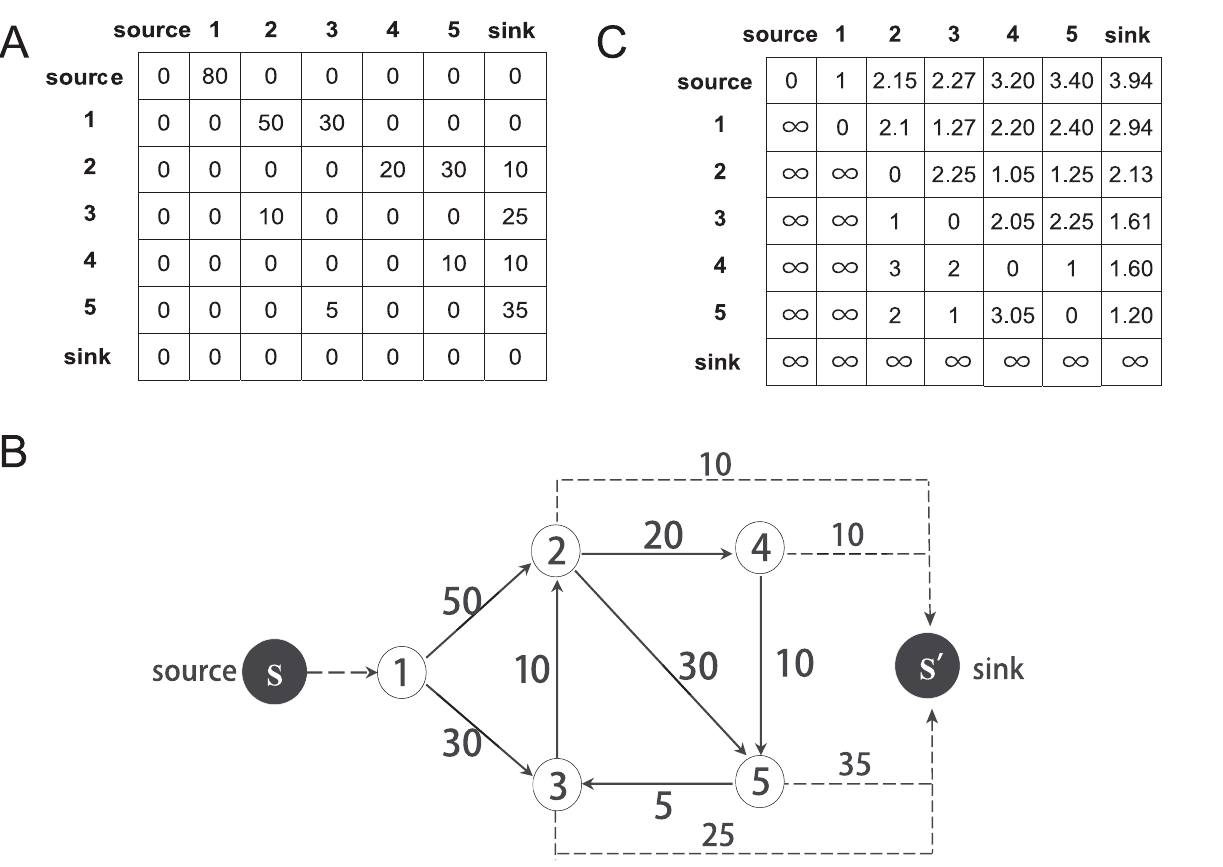
Fig 1. An example attention flow network including 7 nodes. (A)The flux matrix of the example network. Noting that the summation of all the elements in the ith column equals to the summation for the ith row except “ source ” and “ sink ” , thus, the network is balanced. (B) The original example open flow network. (C) shows the flow distances among websites, where infinity means that there is no connected path from i to j .